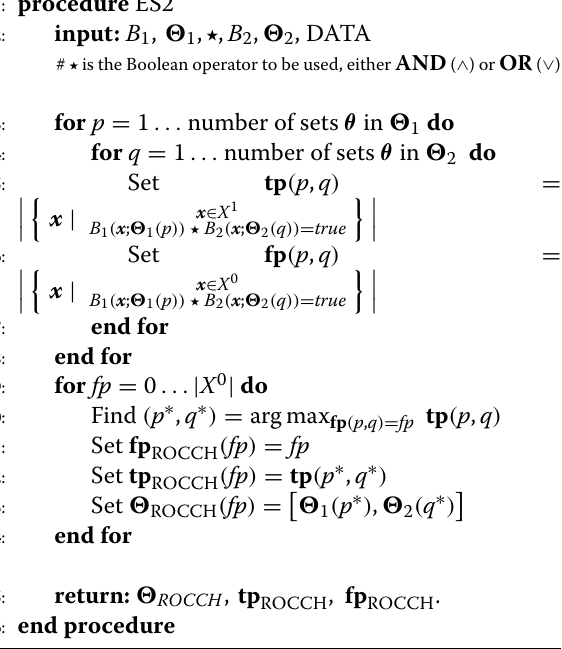
Algorithm 2 An algorithm to find thresholds for a BOA combination with IES or BAROC procedure